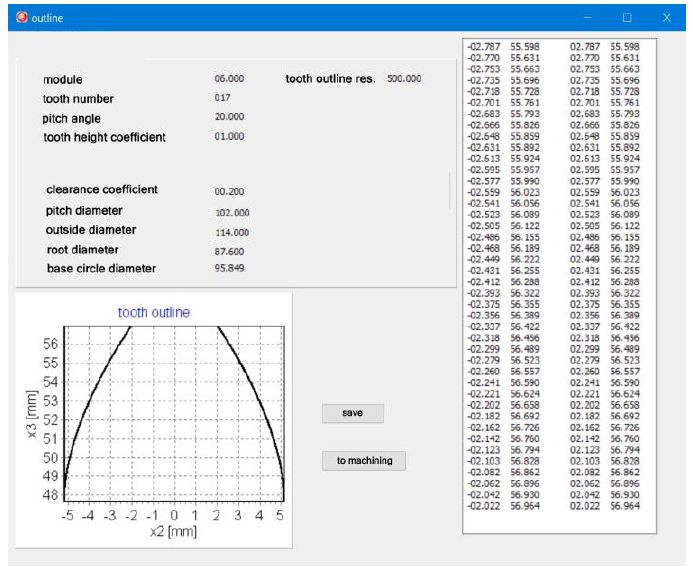
Figure 4. A tooth outline and tool path generating software.